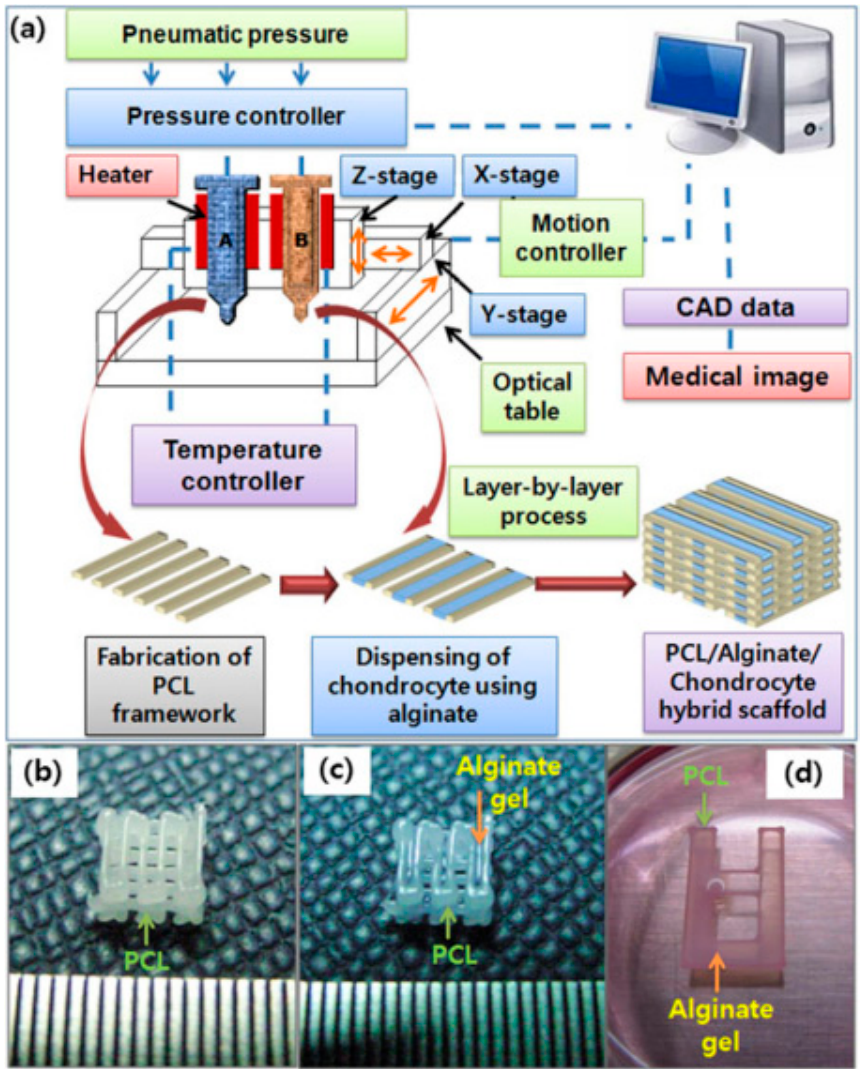
Figure 5. ( a ) Schematics of the fabrication process of cell-printed 3D polycaprolactone (PCL)–alginate gel hybrid scaffold using a multihead deposition system; Photo-images of: ( b ) fabricated porous 3D PCL scaffold; ( c ) chondrocyte-printed 3D PCL–alginate gel hybrid scaffold for in vivo experiments; and ( d ) simplified 2D hybrid scaffold for in vitro experiments [56].